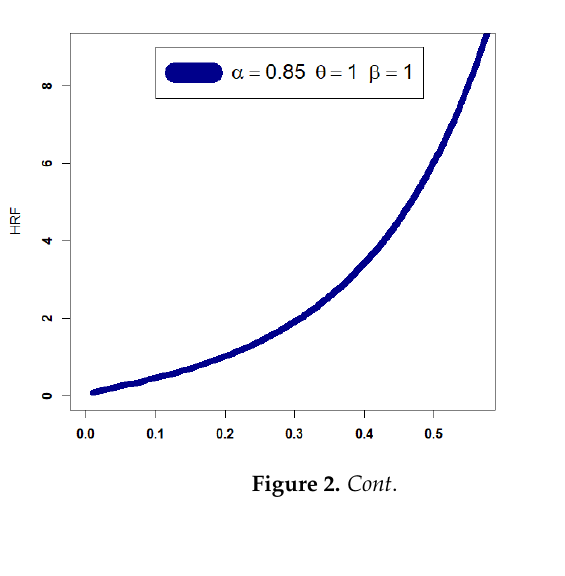
Figure 1. Some PDF plots.